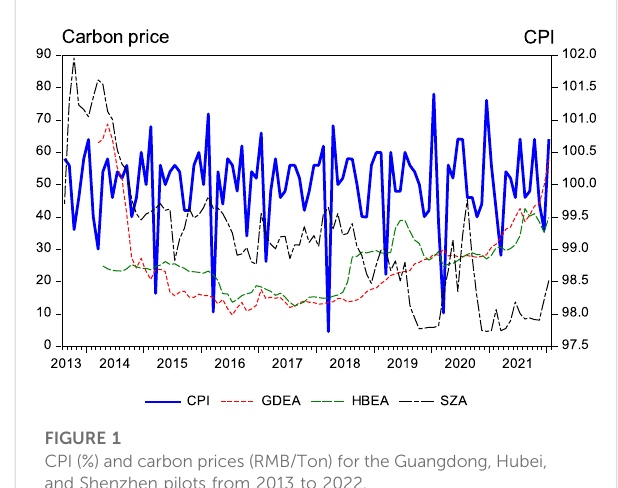
CPI (%) and carbon prices (RMB/Ton) for the Guangdong, Hubei, and Shenzhen pilots from 2013 to